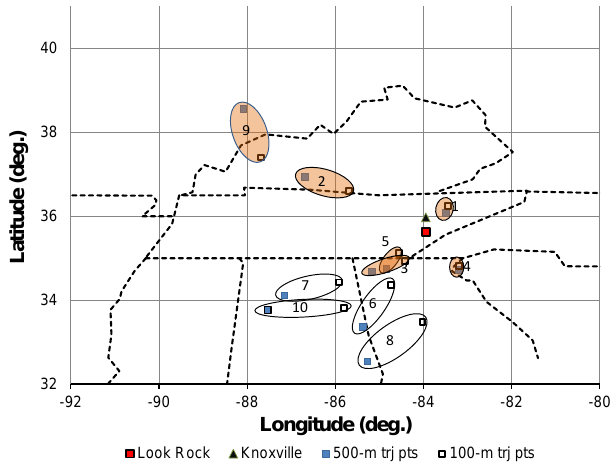
Figure 12. Locations of cluster centroids (numbered ellipses) for computed 100 and 500m air trajectories at 12h upwind (pairs of squares within ellipses) from Look Rock (red square) for selected extreme PM 2 . 5 episodes during 2007–2013. Shaded ellipses denote clusters for which significant negative PM 2 . 5 mass trends at Look Rock were identified. increased PM 2 . 5 over time, the weighted trend remains neg- ative when higher-order/lower-numbered clusters are added together (see last column in each part of the table). The PM 2 . 5 trend across all trajectories (there is no difference in trajec- tory age because all are associated with the same PM 2 . 5 data) was − 1.35 µg m − 3 yr − 1 , which is significant at the 99 % con- fidence